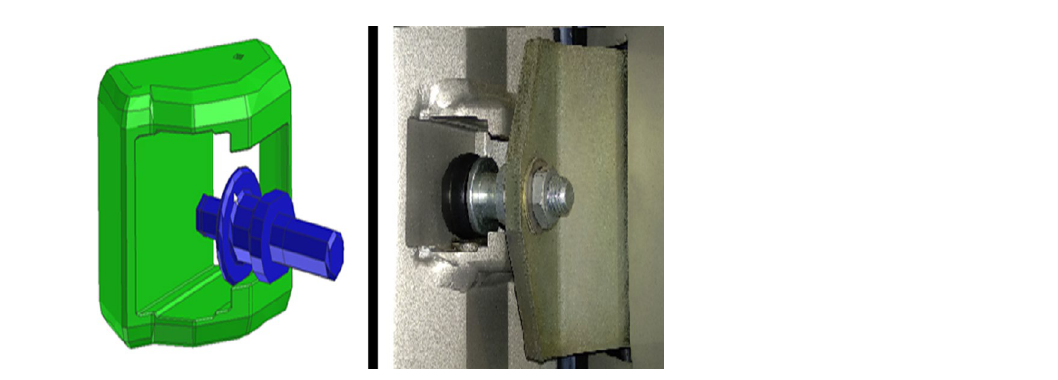
Figure 6. Security backstop